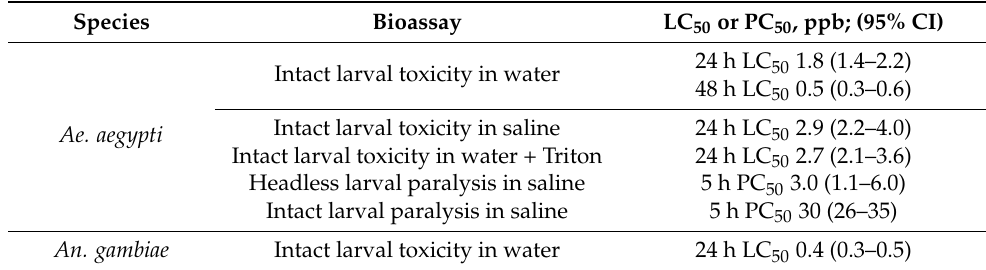
Table 1. Larval bioassays of fluralaner on fourth-instar Ae. aegypti and An. gambiae larvae.